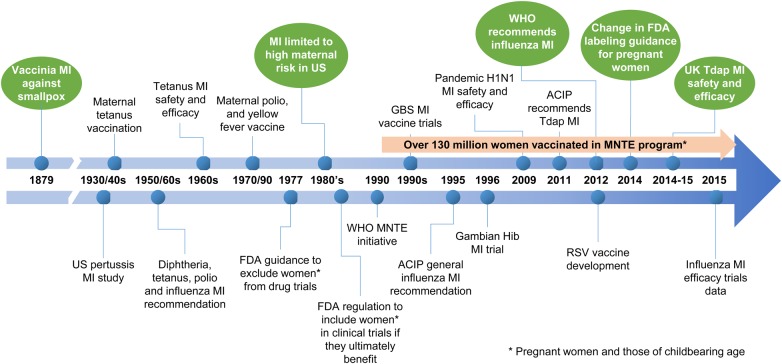
The history of maternal immunization [12]. Abbreviations: ACIP, Advisory Committee on Immunization Practices; FDA, US Food and Drug Administration; GBS, group B Streptococcus; Hib, Haemophilus influenzae type b; MI, maternal immunization; MNTE, maternal neonatal tetanus elimination; RSV, respiratory syncytial virus; Tdap, reduced-dose tetanus-diphtheria-acellular pertussis vaccine; WHO, World Health Organization.